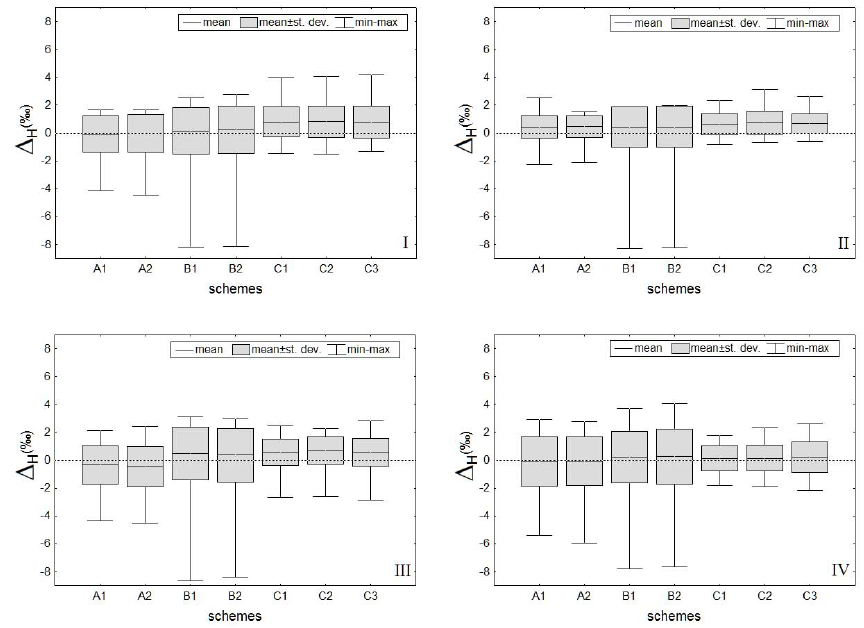
Fig. 2. Descriptive statistics of δ 2 H laser spectroscope-mass spectrometer deviations for the different analytic schemes and for the four analyzers.